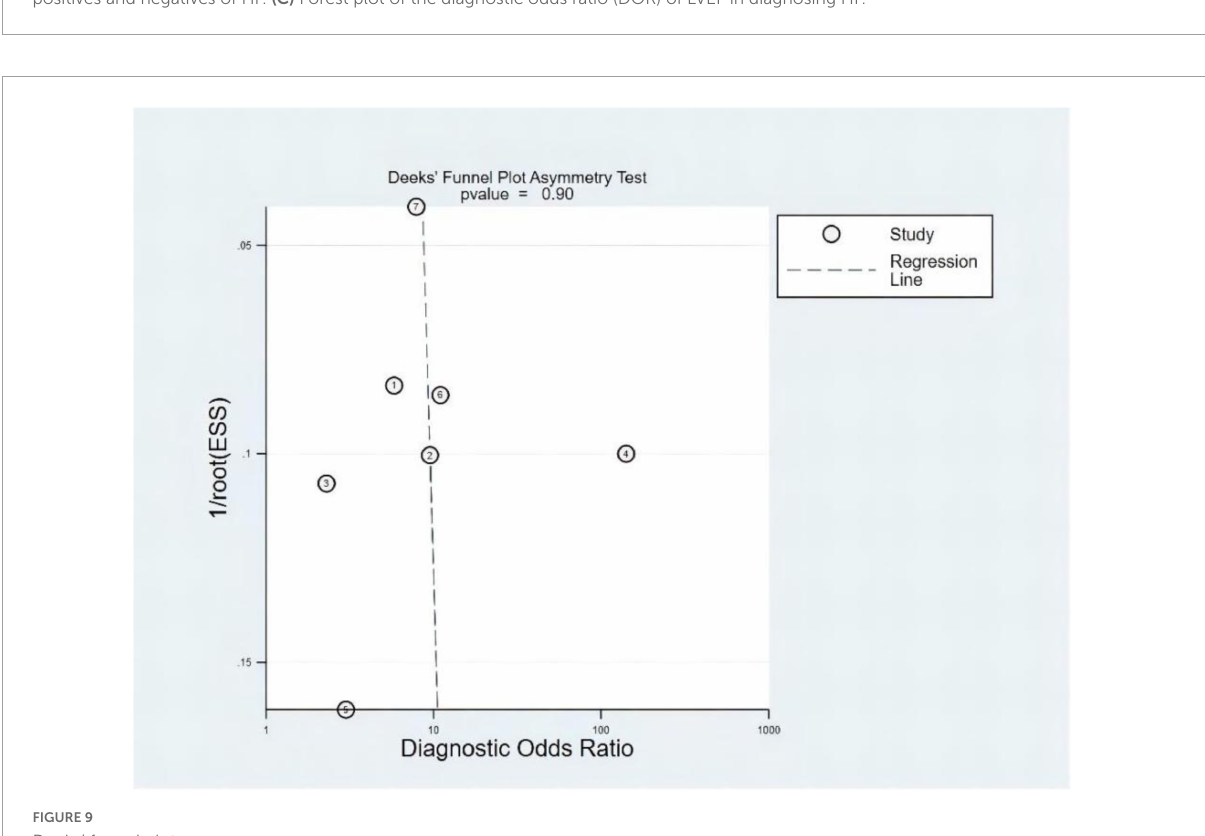
FIGURE9 Deeks’ funnel